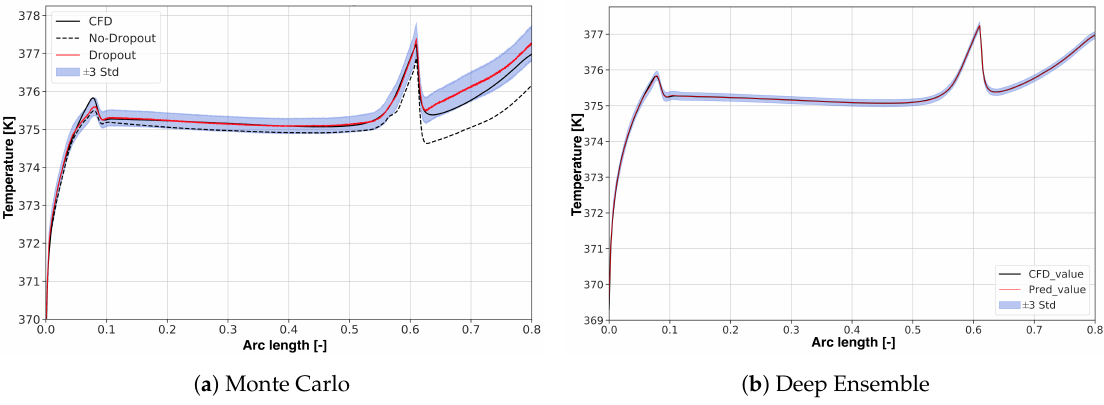
Figure 8. Wall temperature profile along arc length for interpolation dataset using Monte Carlo and Deep Ensemble models at q (cid:48)(cid:48) = 14,000 Wm − 2 and u = 0.05 ms − 1